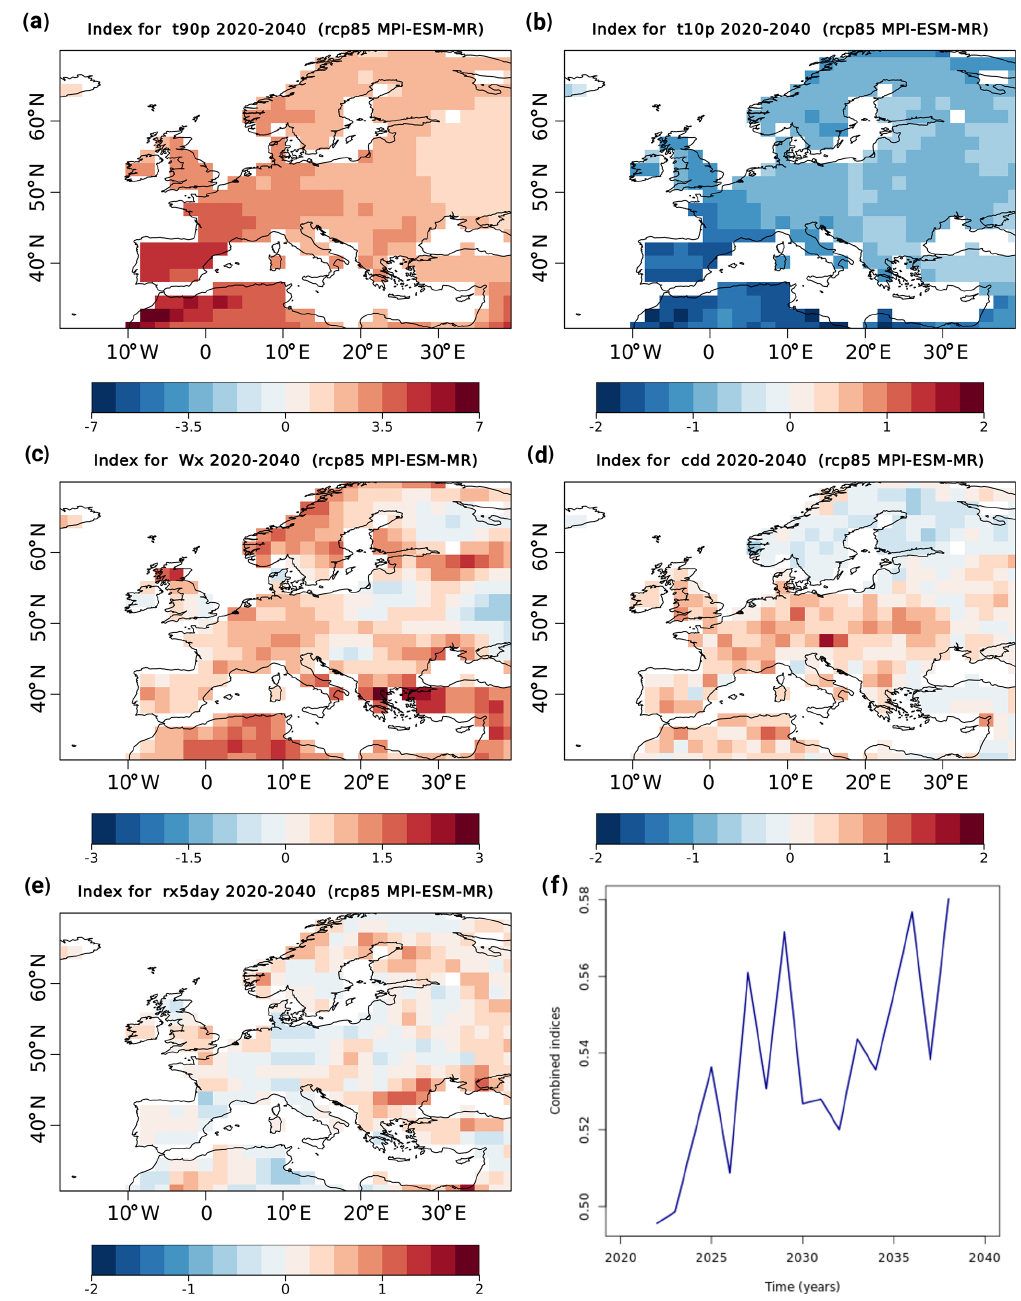
Figure 9. (a–e) Average change in each of the components of the combined climate extreme index for the time period 2020–2040 compared to the 1971–2000 reference period: (a) upper temperature percentile, (b) lower temperature percentile, (c) wind, (d) drought, (e) maximum precipitation. Panel (f) shows a time series for the combined index for 2020–2040. The results are shown for the RCP8.5 scenario simulated by MPI-ESM-MR (see Sect. 3.3.2 for details on recipe_extreme_index.yml